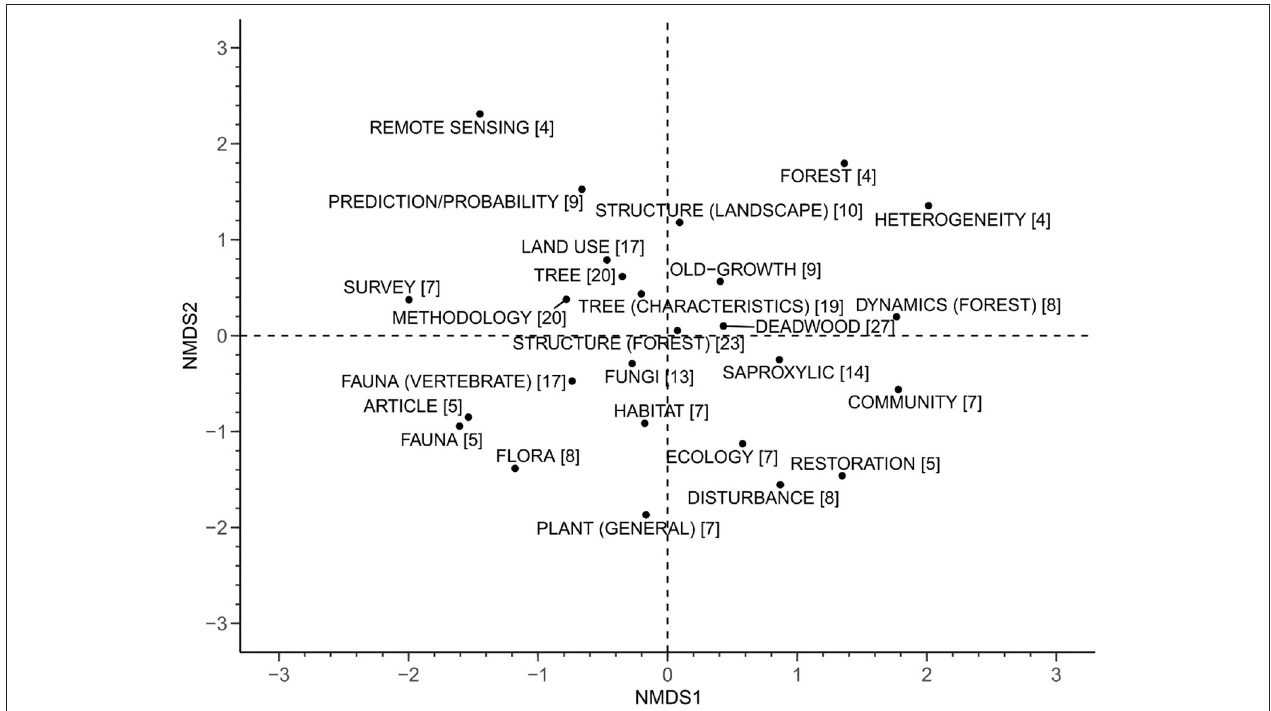
FIGURE 5 | Biplot of the results of the NMDS on the first and second ordination axes (NMDS1 and NDMS2, respectively). Black dots represent themes ( n = 26), and the number in brackets indicates the number of articles for which the theme was identified.